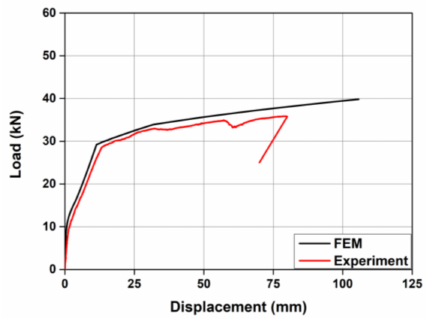
Figure 8. Comparison of load-displacement curves for